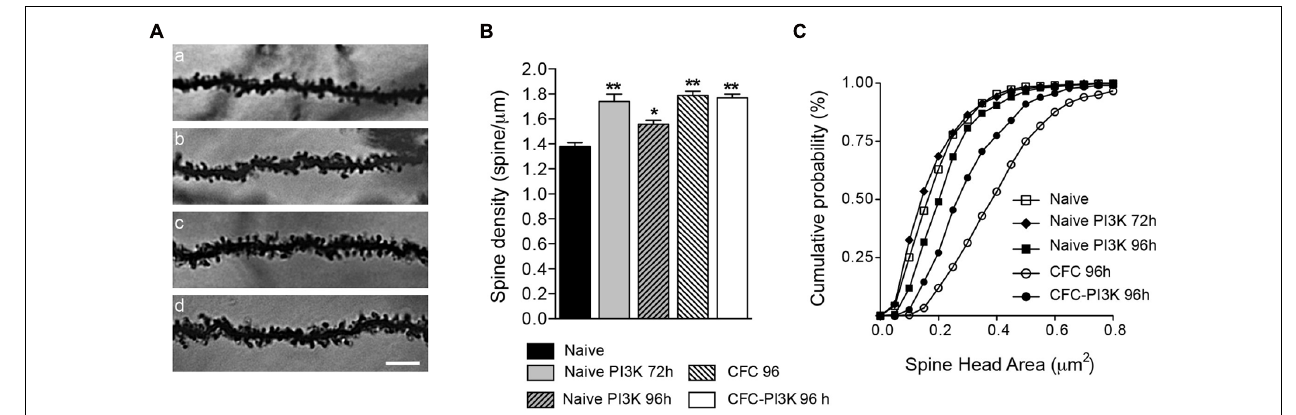
FIGURE 2 | PI3K activation and CFC modified spine density and head area. (A) Representative images (96 h after injection) of stratum oriens dendrites in the CA1 region of the hippocampus from Naive (a), Naive injected with PTD4-PI3KAc (b), CFC (c), and CFC injected with PTD4-PI3KAc (d) animals. Scale bar = 5 μ m. (B) Mean average graph of spine density changes during: naive conditions (1.38 ± 0.03 spines/ μ m), after 72 and 96 h of PI3K activation (1.74 ± 0.06 and 1.56 ± 0.03 spines/ μ m, respectively) and after the CFC test (CFC-96 h; 1.79 ± 0.02 spines/ μ m and CFC-PI3K-96 h: